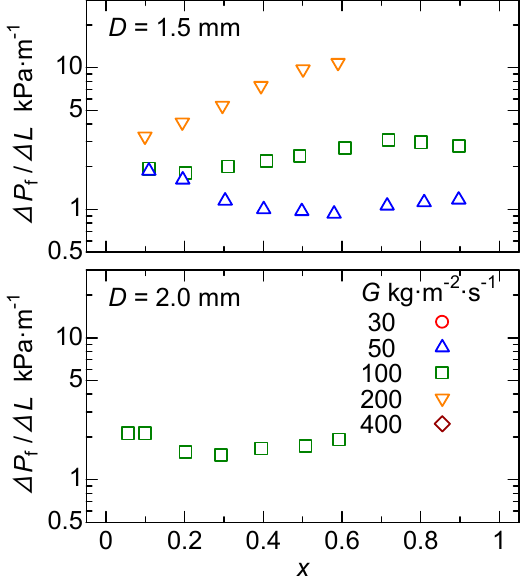
Figure 6. Frictional pressure drop vs. quality in downward flow. (Mass flux is parameter).